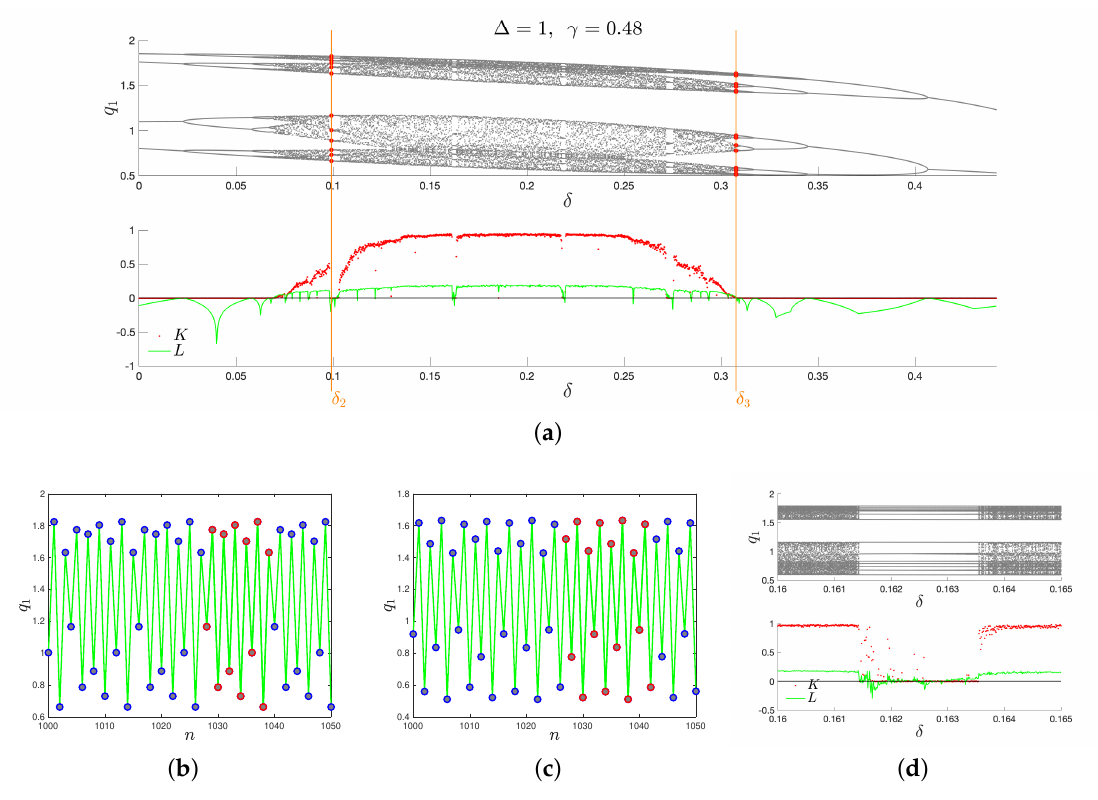
Figure 5. Investigated IHCOM Equation (11), with ∆ = 1 and γ = 0.48, ( a-upper ) BD δ , ( a-lower ) chaos characteristics K and L for q 1 variable, ( b ) time history for δ 2 = 0.0992 (12 stable cycle highlighted by the red mark), ( c ) time history for δ 3 = 0.3078 (16 stable cycle highlighted by the red mark), and ( d ) is magnified part of ( a